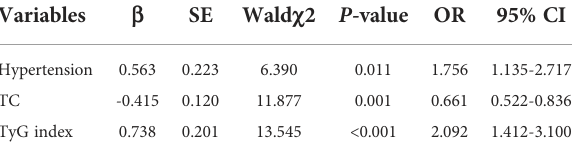
TABLE 3 Multivariate logistic regression analysis of risk factors for AF in all subjects.